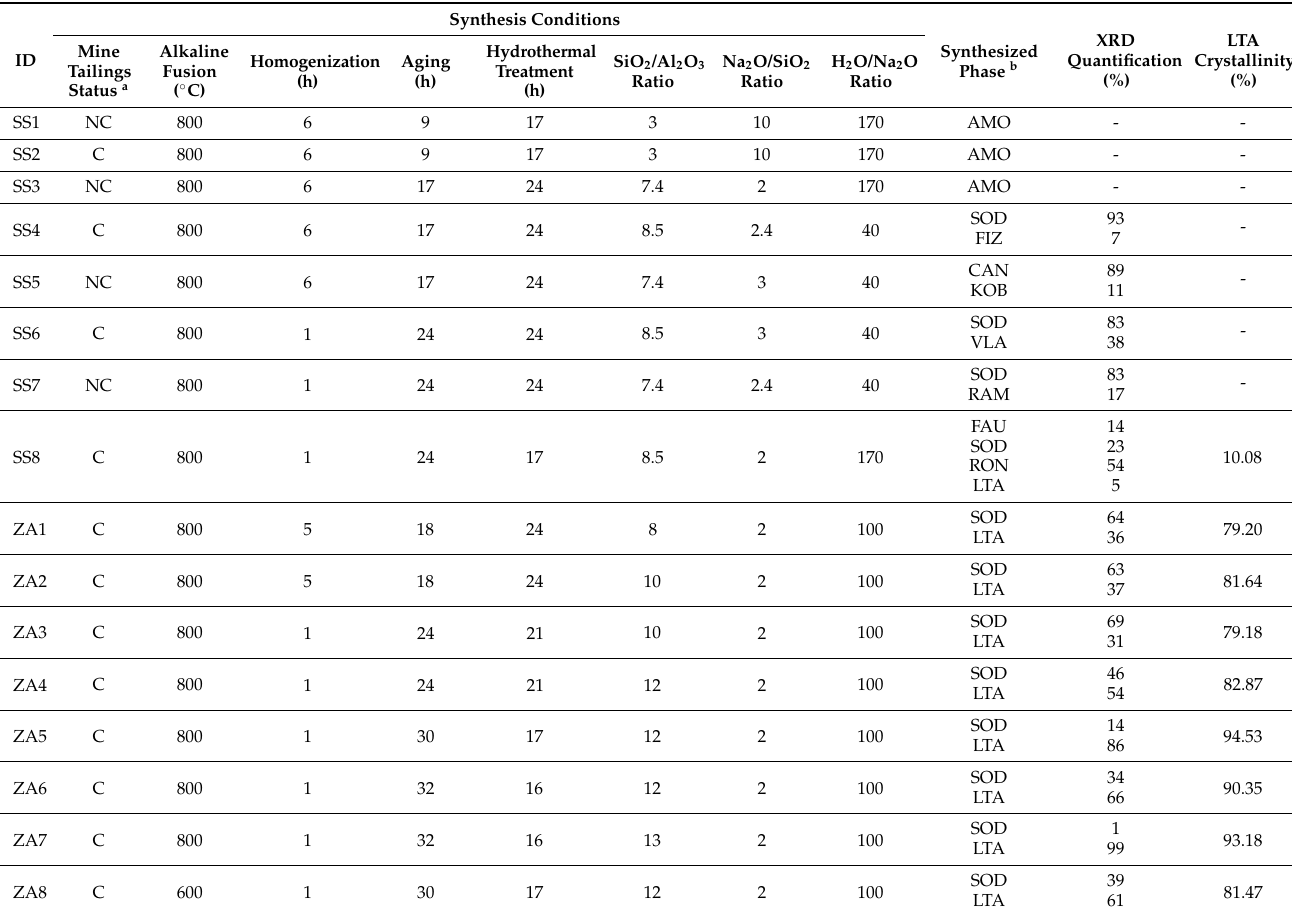
Table 2. Experimental conditions and products obtained from synthesis assays.